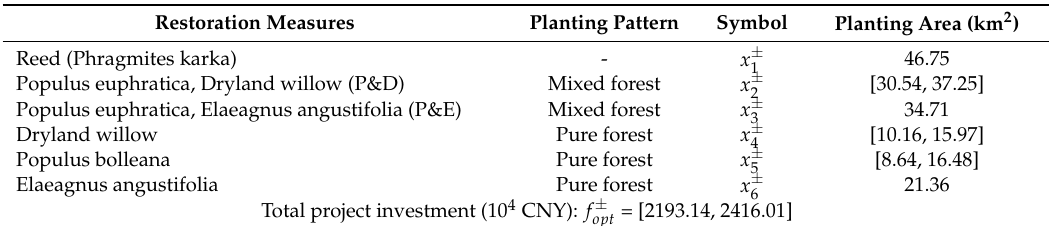
Table 2. Optimal solutions obtained from the